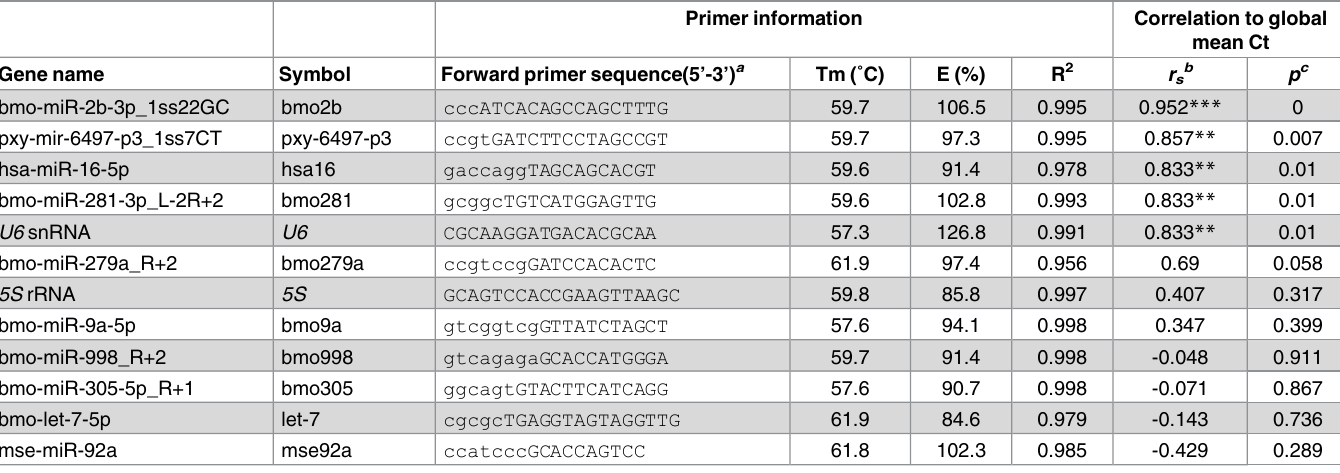
Table 5. Information of candidate reference genes used for qRT-PCR.